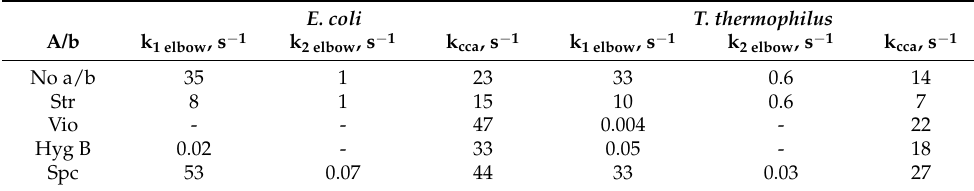
Rate constants determined at 5 µM EF-G. No influence of antibiotics on k 2 of CCA movement was detected. Standard error of the mean did not exceed ±8%. A/b—antibiotic; Str—streptomycin; Vio—viomycin; Hyg B—hygromycin B; Spc—spectinomycin.